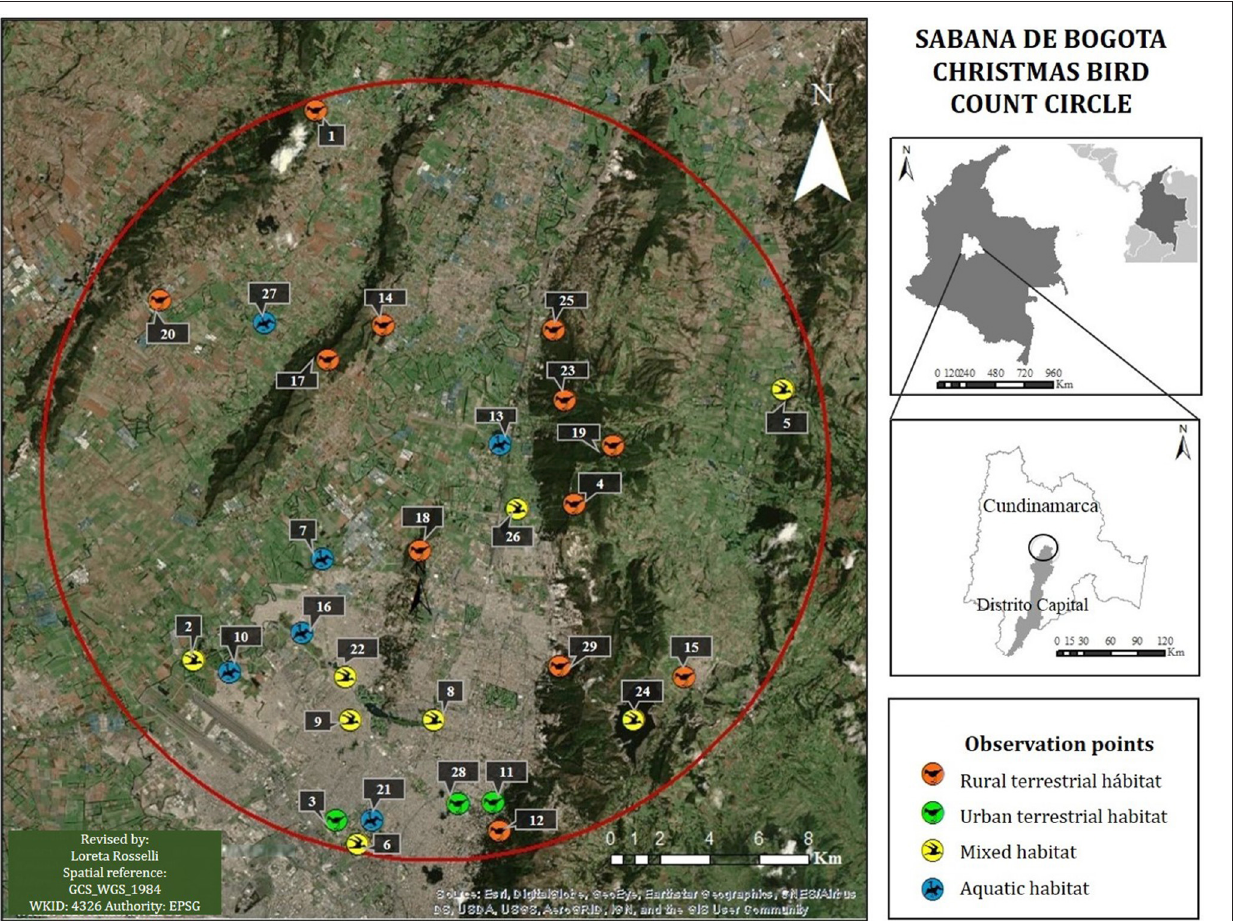
FIGURE 1 | Study area. Location of the Sabana de Bogotá Audubon’s Christmas Bird Count circle and the 29 locations visited between 1989 and 2014. Habitat types were assigned according to dominant land covers in each place (more details about habitats in Section Audubon’s Christmas Bird Count Methods and Circle).